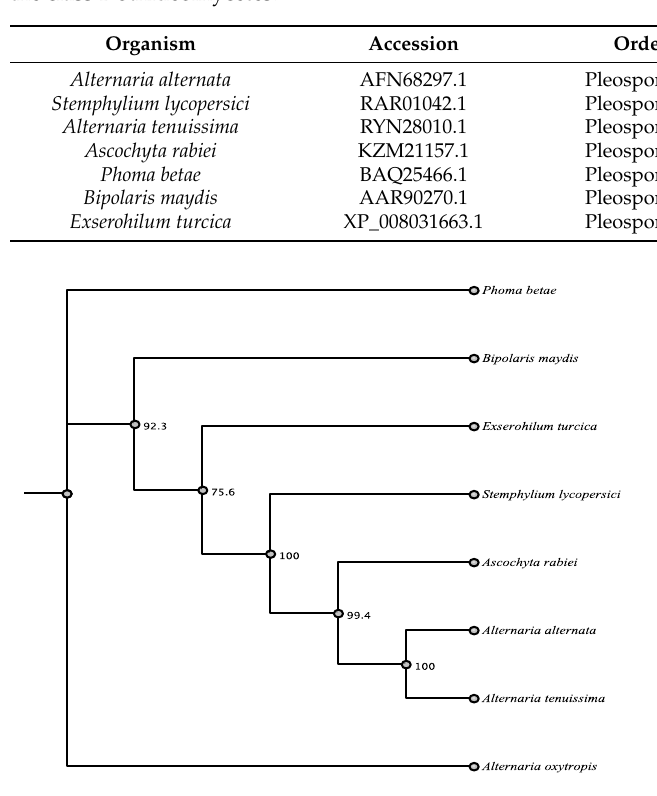
Figure 4. Maximum parsimony tree (MUSCLE alignment and 1000 replicates). Bipolaris maydis was used as the outgroup. Fungi in tree are pblast results of 96133 sequence. Table 5. Percent amino acid (aa) identity of pblast results of PKS 96133 sequence. Fungal order within the class Dothideomycetes.